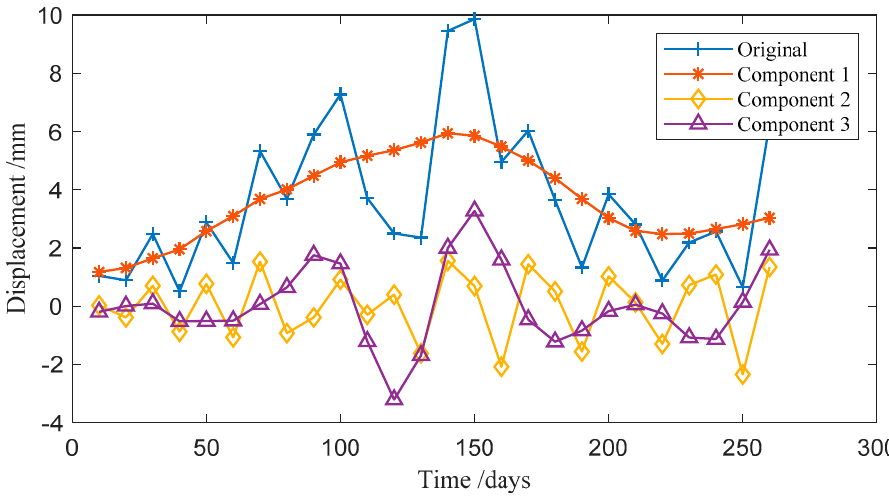
Figure 7. Decomposition results of original displacement for training set.